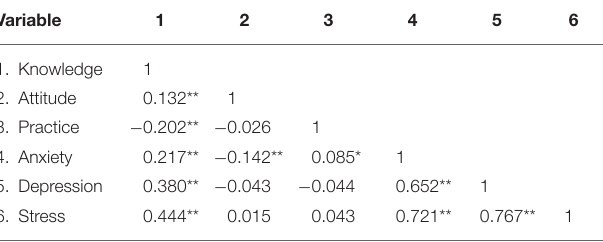
TABLE 3 | Correlation between the gender, age, family structure, social media use and duration, knowledge, attitude, and practices regarding the coronavirus disease 2019 (COVID-19), and anxiety, depression, and stress levels ( n = 800). Variable